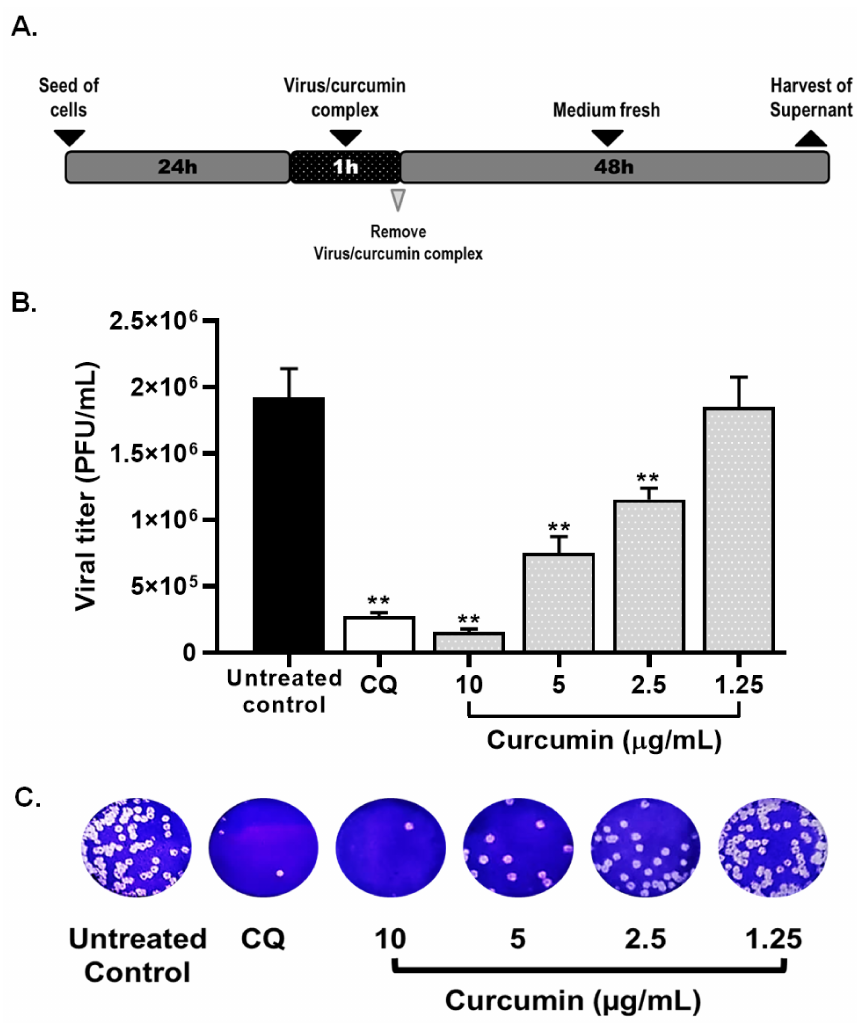
Figure 6. Curcumin inhibited SARS-CoV-2 infectivity under the co-treatment condition. ( A ) Repre- sentative scheme of co-treatment strategy. ( B ) The figure represents the reduction of D614G strain titer (PFU/mL) on Vero E6 supernatants after co-treatment treatment with curcumin (from 1.25 to 10 µ g/mL). Chloroquine (CQ) was used as a positive control of viral inhibition. Data were presented as median ± IQR (n = 4). Mann–Whitney test ** p ≤ 0.01. Inhibition percentages of 92%, 60.4%, 39.3%, and 2.3% were obtained at 10, 5, 2.5, and 1.25 µ g/mL of curcumin, respectively. ( C ) Representative plaques on Vero E6 cells of the co-treatment strategy of curcumin against SARS-CoV-2 D614G